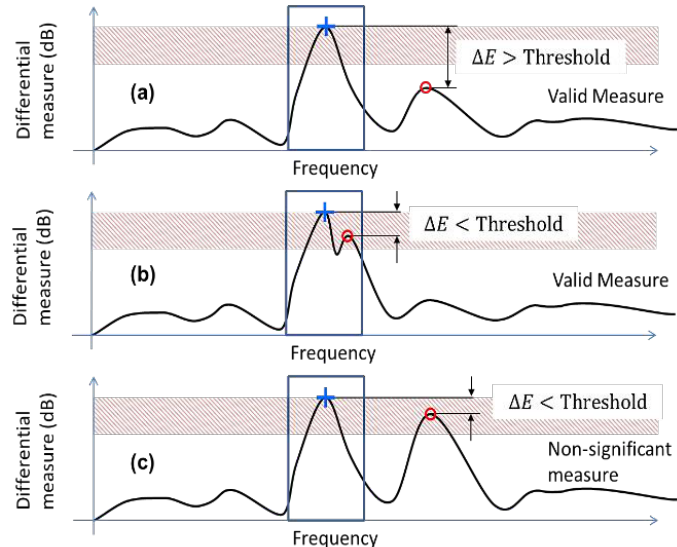
Figure 16. Conditions for ripples removal and valid detections: ( a ) Two peaks appear at two separate frequency slots with apex difference higher than threshold value. ( b ) Two peaks appear at same slots with apex difference less than threshold value. ( c ) Two peaks appear at two separate frequency slots with apex difference lower than threshold value.